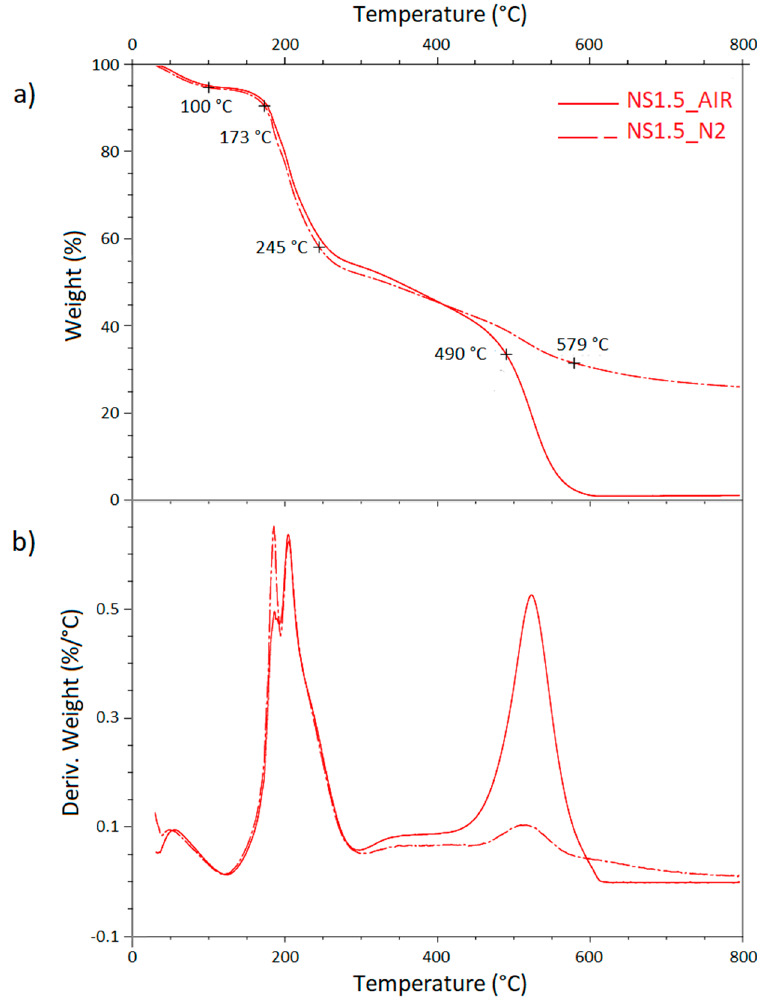
Figure 2. TG ( a ) and DTG ( b ) plots obtained under air or N 2 (solid or dotted lines, respectively) of NS1.5. The specified temperatures refer to the onset and offset degradation temperatures. Table 3. TGA residues at 800 ◦ C under N 2 flow of nanosponges and of PMDA and GLU. Sample Residue